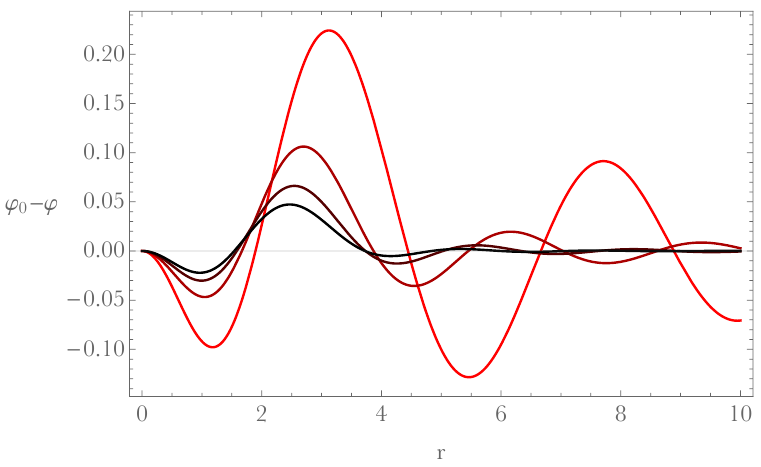
Figure 1 . Comparison of the exact solution ’ to the large D solution ’ 0 for D = 4 ; 6 ; 8 ; 10. We see that the approximation improves with increasing D